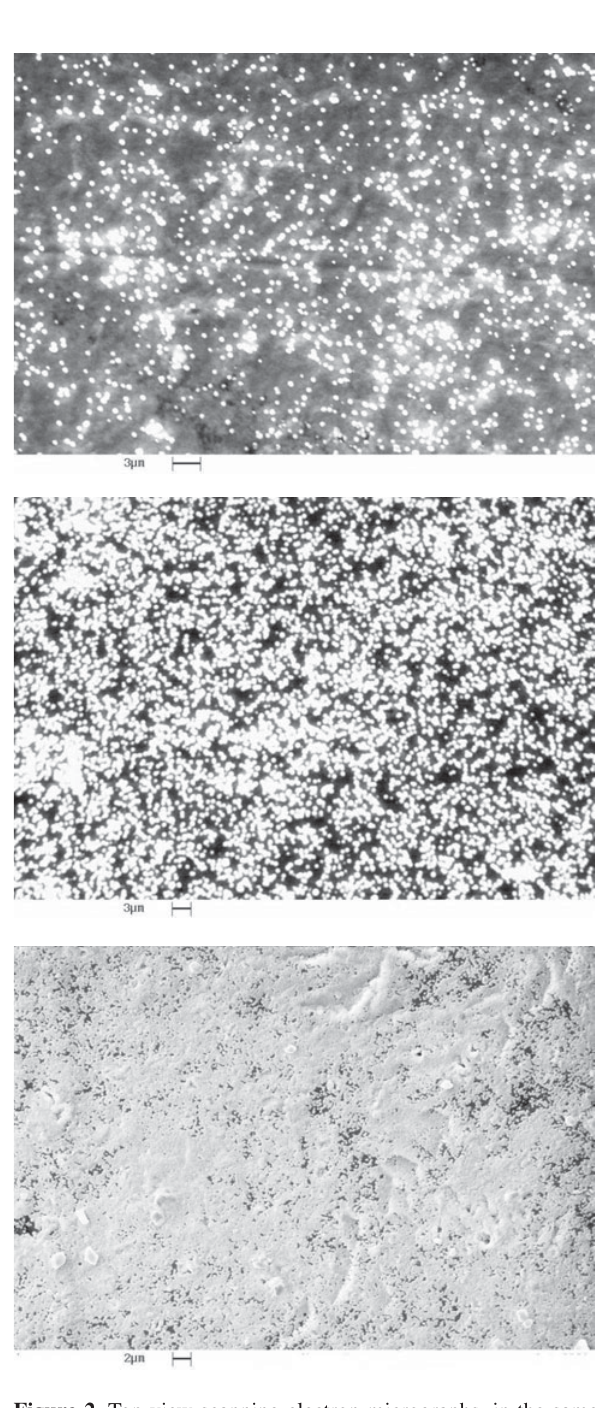
Figure 3. Diamond nucleation density as function of applied bias